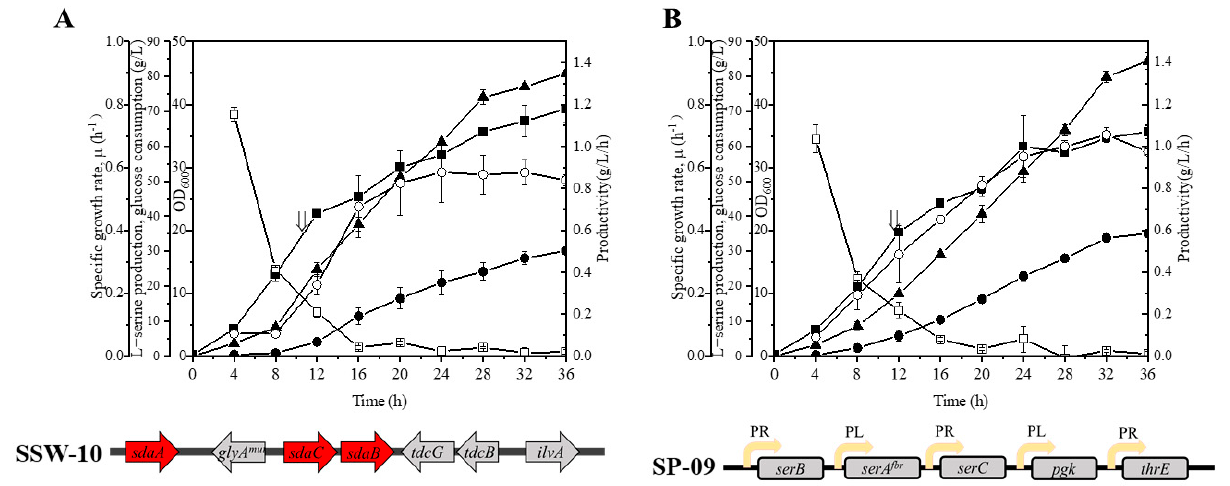
Figure 5. L-serine production by SSW-10/SP-08 and SSW-10/SP-09 during fed-batch fermentation. ( A ) L-serine production by and growth of SSW-011/SP-08 cells. ( B ) L-serine production and cell density achieved by SSW-10/SP-09. The genes marked in red indicate targets for knockout. The yellow arrow with PR or PL indicates PR or PL promoter. Cell growth (filled squares), L-serine concentration (filled circles), glucose consumption (upward-pointing filled triangles), specific growth rate (open squares), and L-serine productivity (open circles). The arrow indicates the starting point of induction. The data are presented as the means ± SDs from three measurements.